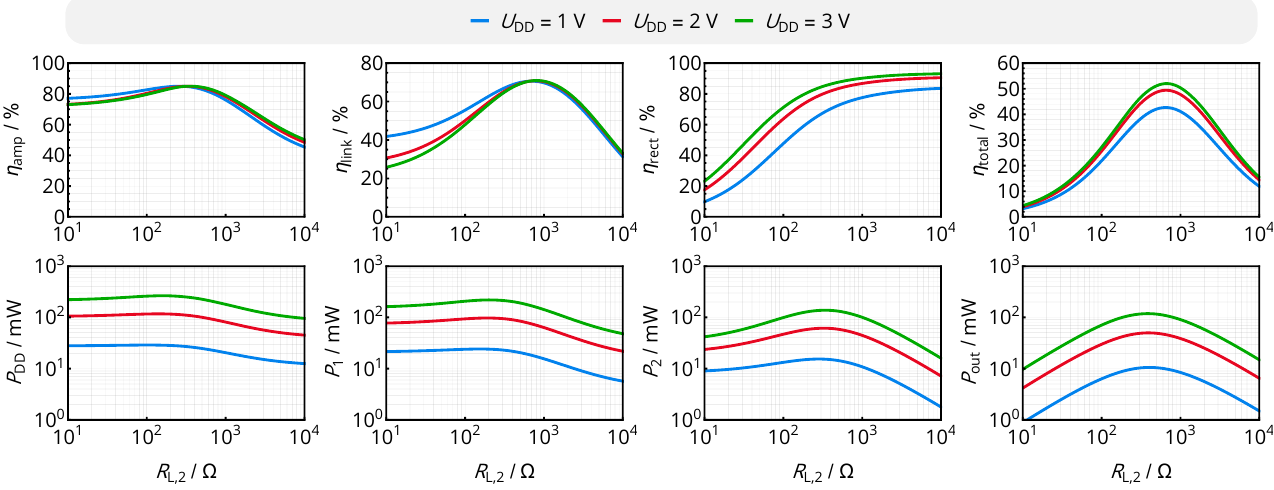
Figure 5. Power and efficiency levels of the main components of the WPT interface versus the DC load resistance R L,2 . All components’ efficiency levels scale differently with load resistance and different overall power levels determined by U DD . The overall efficiency η total is still optimized by a dedicated DC load resistance R L,2